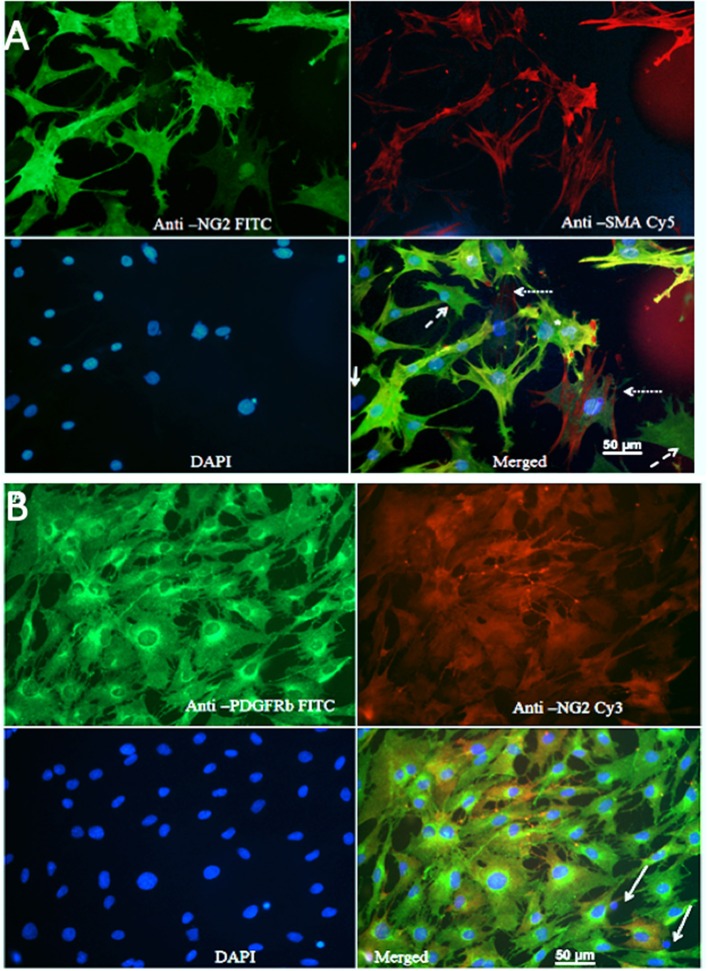
(A) Staining of primary cultures with anti-NG2 (FITC, green channel)/anti-SMA antibodies (Cy5, red channel). These images show polygonal, pericyte-like cells with processes. Anti-NG2 was mostly diffuse diffusely, while staining with anti SMA revealed fibrillary structures, which most likely corresponded to actin filaments. Cells that were poorly stained with both NG2 and SMA could be observed rarely (arrows); some cells were positive only for NG2 (dashed arrows), while some cells were mainly SMA positive (dotted arrow). (B) Immunostaining for PDGFRβ. A typical image showing staining of primary cultures with anti PDGFRβ (FITC, green)/anti-NG2 antibodies (Cy3, red).